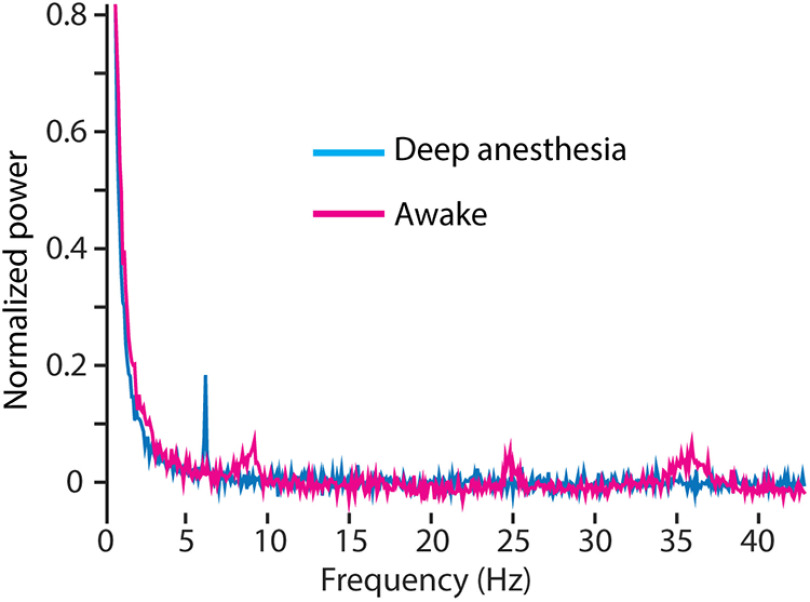
Gamma and other oscillations disappear under deep anesthesia. Spectrum recorded under awake conditions (magenta) was acquired 30 min after allowing the mouse to wake up from deep anesthesia (>1% isoflurane, temperature control set to 34°C, blue). Theta, beta, and gamma activity bands arise as the mouse wakes up. Each trace is the average of 30 recordings, 11-second each, at a depth of 40 μm below dura.